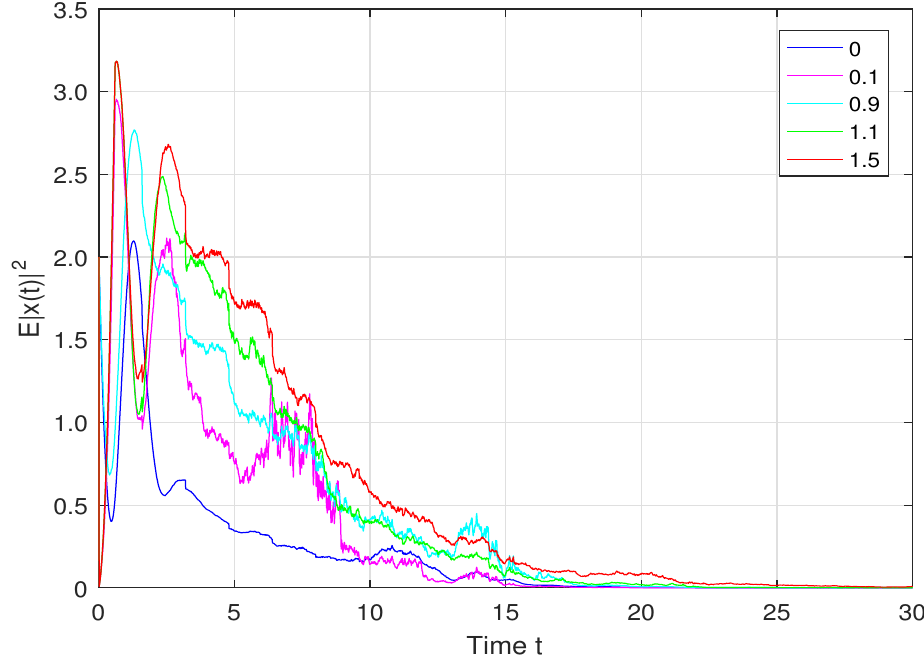
Figure 3. The curve of mean-square for different δ 1